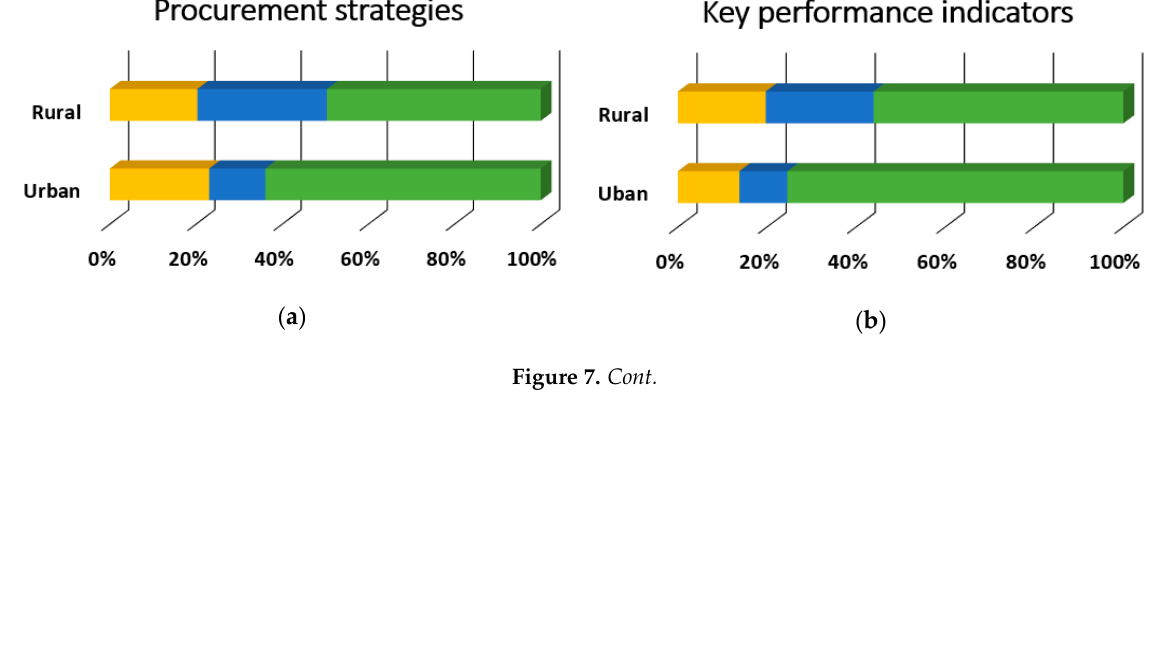
Figure 6. Communications and Marketing training topic needs that significantly differed by participant role, n = 453 (food service director, n = 152; food service manager, n=110; other food service staff, n = 63; school staff, n = 128). Described below for each panel are the χ 2 and p -values. CNP = Child Nutrition Programs. ( a ) Customer service, χ 2 (6) = 30.0, p < 0.001, Cramer’s V = 0.18; ( b ) Marketing child nutrition programs to school staff, χ 2 (6) = 56.6, p < 0.001, Cramer’s V = 0.25; ( c ) Marketing child nutrition programs to students and families, χ 2 (6) = 31.1, p < 0.001, Cramer’s V = 0.19; ( d ) Using social media to promote child nutrition programs, χ 2 (6) = 34.5, p < 0.001, Cramer’s V = 0.20; ( e ) Smarter Lunchrooms and food merchandising techniques, χ 2 (6) = 61.7, p < 0.001, Cramer’s V = 0.26; ( f ) Increasing student engagement and involvement, χ 2 (6) = 49.2, p < 0.001, Cramer’s V = 0.23.